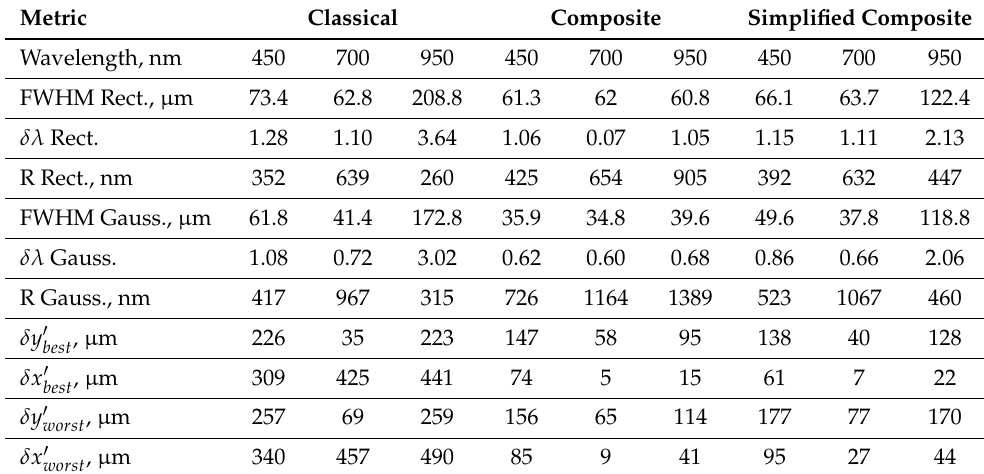
Table 2. Image quality metrics of the slitless spectrograph. Metric Classical Composite Simplified